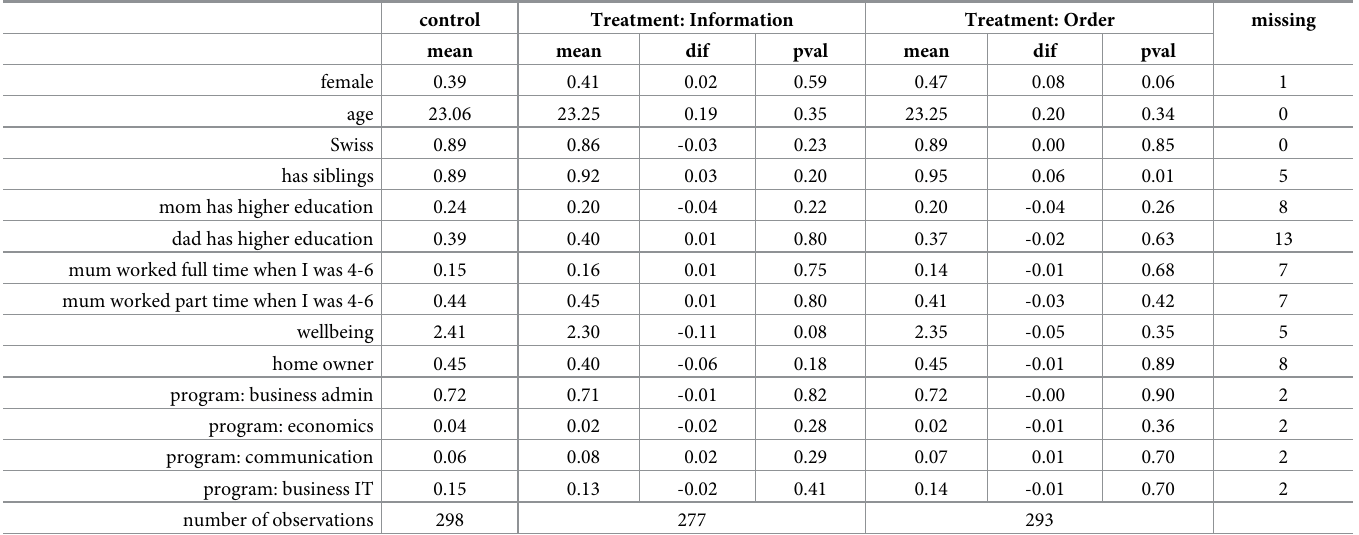
Table 3. Descriptives for